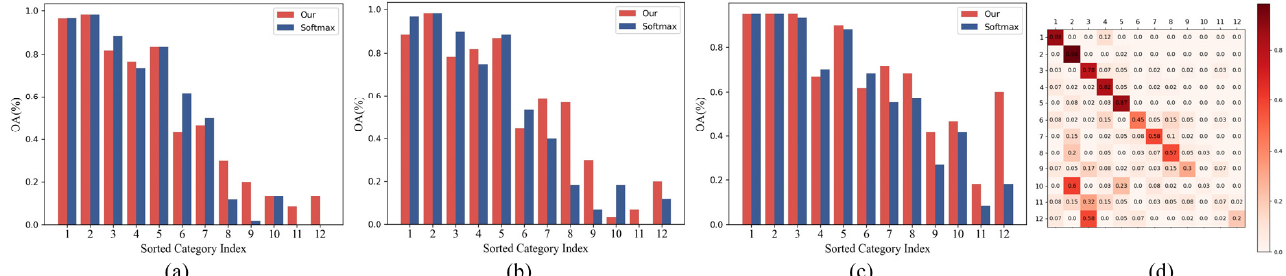
Figure 7. ( a – c ) show the classification accuracy of the proposed method and Softmax cross ‐ entropy method for samples from each category in the long-tailed SIRI-WHU dataset with imbalance ratios of 0.01,0.02 and 0.05, respectively. ( d ) shows the classification confusion matrix of the proposed method on the long-tailed SIRI-WHU dataset with an imbalance ratio of 0.02.